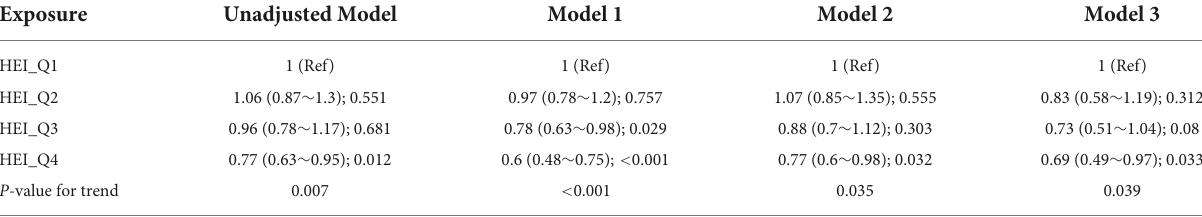
TABLE 3 Association of HEI-2015 with periodontitis.